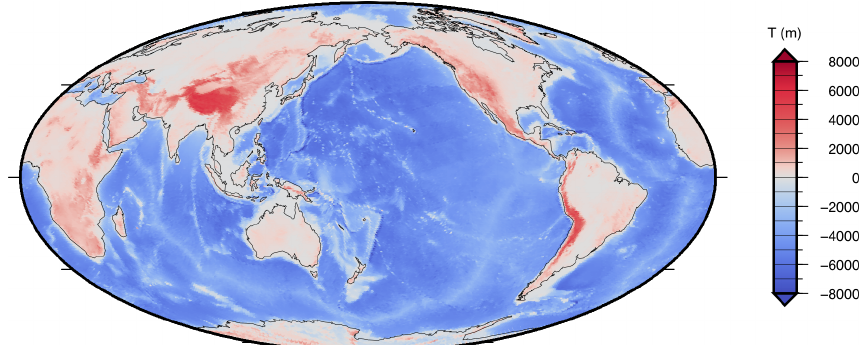
Figure 2. Present-day relief according to model ETO-R44 used in the test run, obtained from model ETOPO1 by bilinear interpolation on the pixels of the Tegmark grid with resolution R = 44, using the GMT program grdtrack